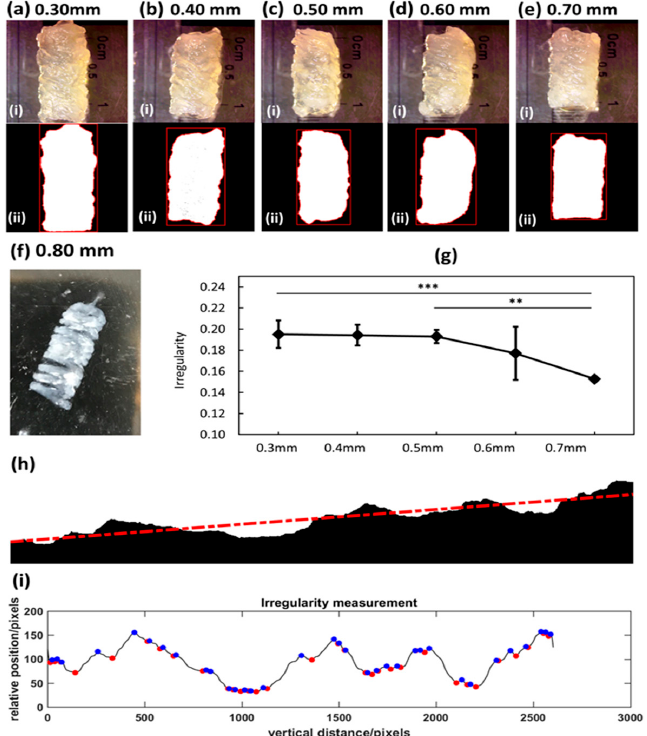
Figure 5. The effect of layer height on the printed construct shape quality: ( a – e ) The (i) of ( a – e ) are images of printed tubular structures with different layer heights (flowrate of 4.8 mL/h and travel speed of 200 mm/min), and (ii) of ( a – e ) are binary images with boundary box; ( f ) disconnected tubular structure with layer height of 0.8 mm; ( g ) the irregularity of the outer surface of the printed tube; ( h ) binary image segment shows the details of the outer surface of the printed tubular structure, red line is the fitted linear model representing the reference line; ( i ) the projected and filtered surface wave with detected local maximum and minimum points.